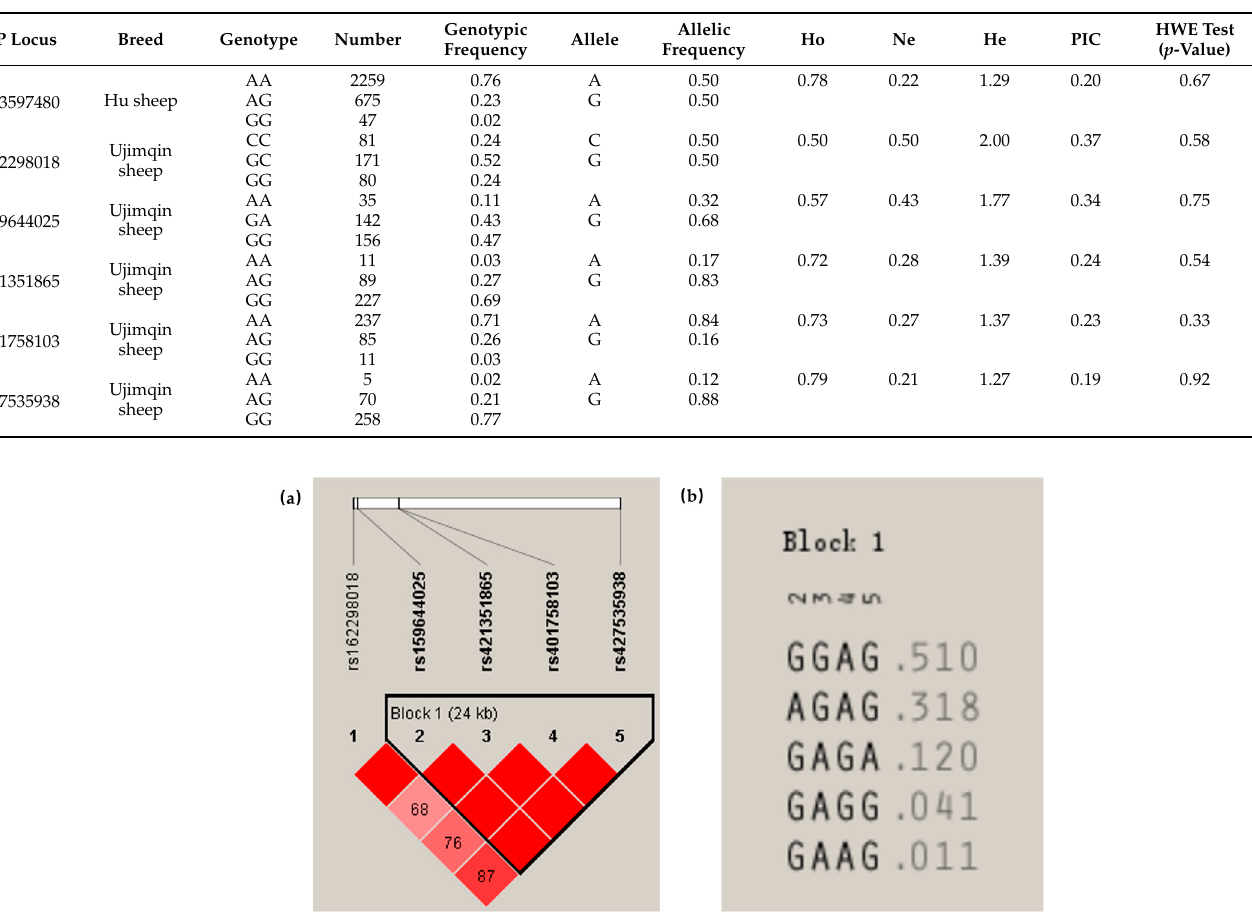
Table 2. Genetic parameters of the single-nucleotide polymorphism (SNP) markers of the ARNT gene in the Hu and Ujimqin sheep.